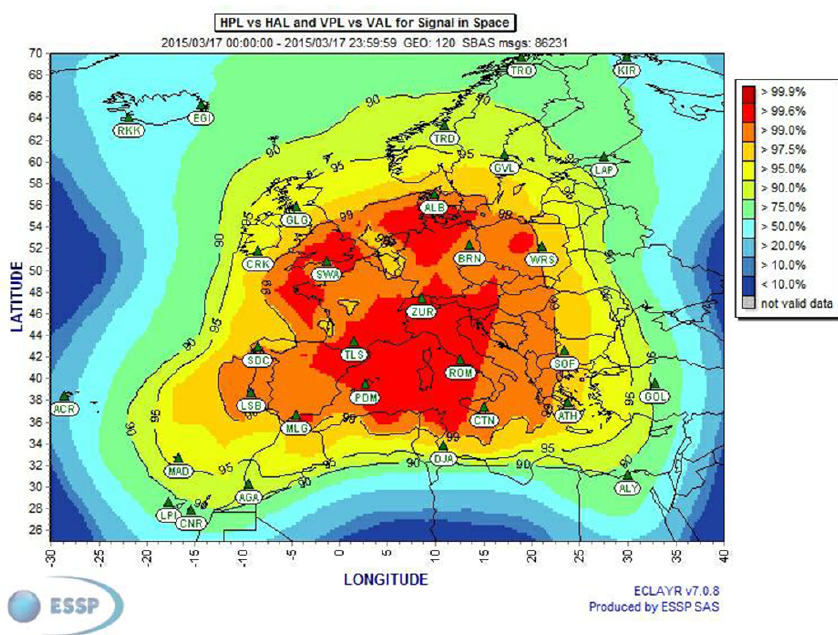
Figure 22. APV-I availability maps for the period of the St. Patrick’s Day storm for the 17 and 18 March 2015 (credits: ESSP; https: